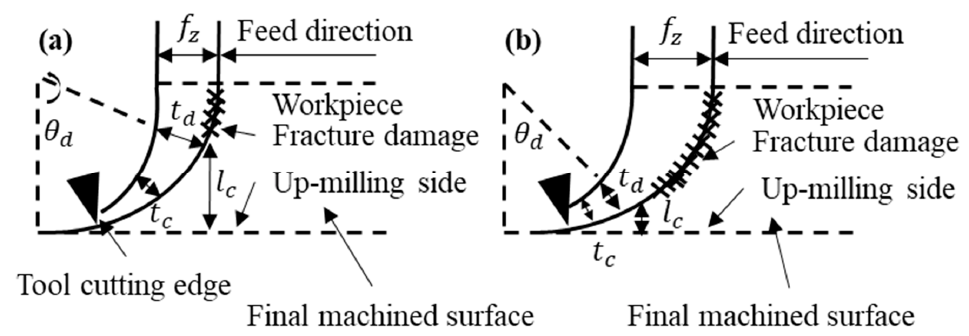
Figure 1. Relationship between feed rate, f (cid:2910) f (cid:2910) , and subsurface damage depth, l (cid:2913) l (cid:2913) , during up-milling for ( a ) low feed rate and ( b ) high feed